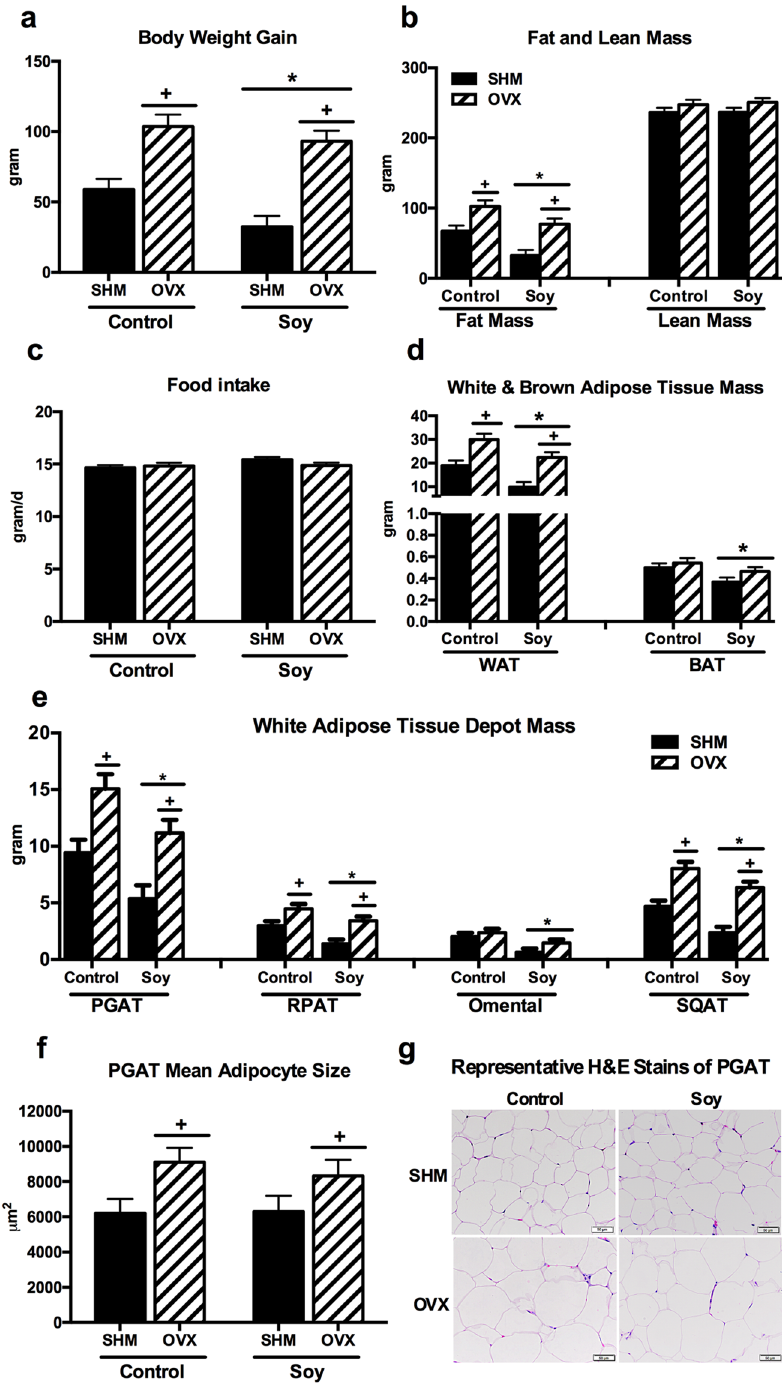
Figure 1. Animal characteristics. OVX led to greater body weight gain ( a ), fat ( b ), and white adipose tissue mass ( d ), while rats fed soy diet gained less body weight, fat, and white adipose tissue mass. Food intake ( c ) was not affected by the treatment, white and brown adipose tissue mass ( d ), white adipose tissue depot mass ( e ), perigonadal adipose tissue (PGAT) mean adipocyte size ( f ), and representative H&E stains of PGAT ( g ) of ovariectomized (OVX) vs. sham-operated (SHM) rats bred for low-running capacity fed either a soy-rich or soy-free diet. Data were analyzed using the Mixed Models procedure of SAS 9.3 with diet and surgery being fixed effects and animal ID being a random effect. When a main effect was significant, post hoc pairwise comparisons were performed using Tukey’s multiple comparison tests. Data are least-squares means ± SEM, n = 4–10. + Denotes main surgery effect (OVX vs. SHM); * Denotes main diet effect (Control vs. Soy), P <